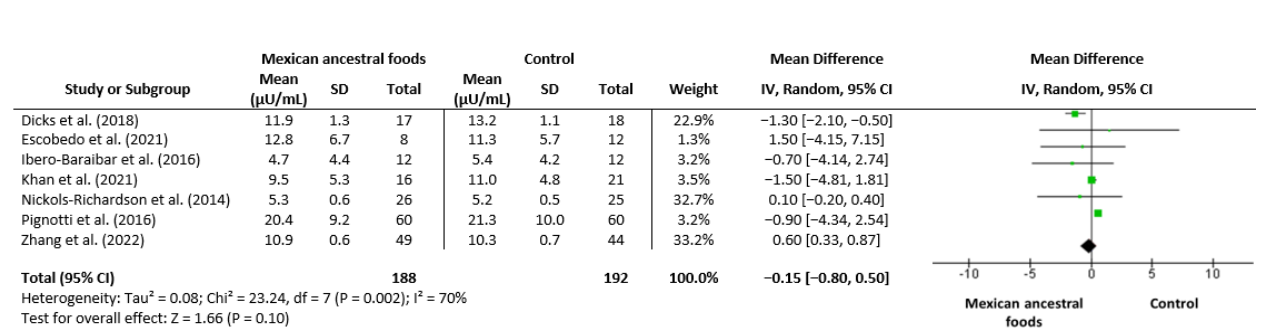
Figure 6. Effect of Mexican ancestral foods supplementation on ( A ) Fasting plasma glucose [29,31 – 35,37,39,41 – 43] , ( B ) HOMA-IR [29,31,34,35,37,39,41,43] and ( C ) Insulin [29,31,34,37,39,41,43] . All data are presented as mean ± standard deviation and confidence interval is 95% (CI). Study weights were assigned using the inverse variance method and random-effects model. The diamond ( ) represents the overall effect estimate of the meta-analysis and the green point ( ) represents mean difference of effect measure of each study.